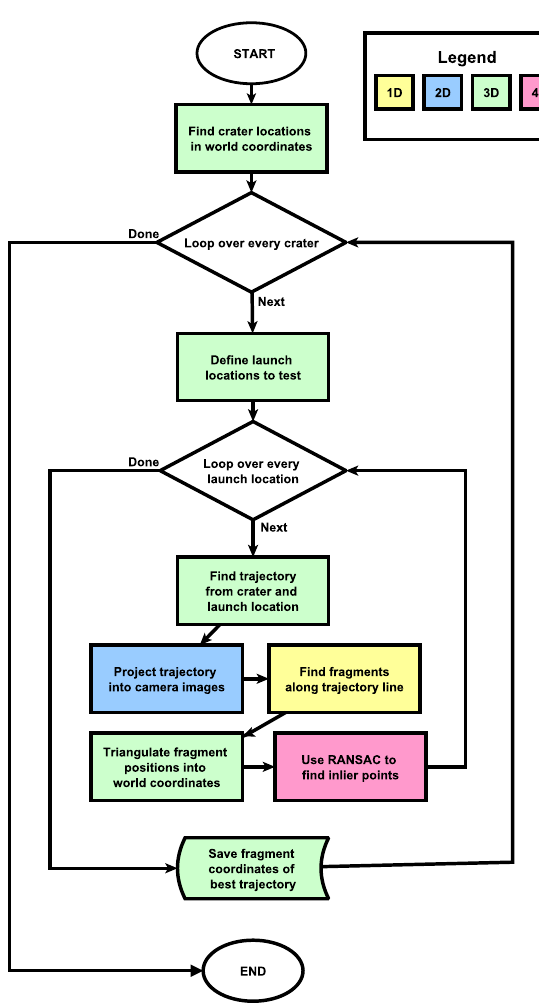
Figure 7. Flowchart of algorithm for identifying fragments based on a trajectory search method.